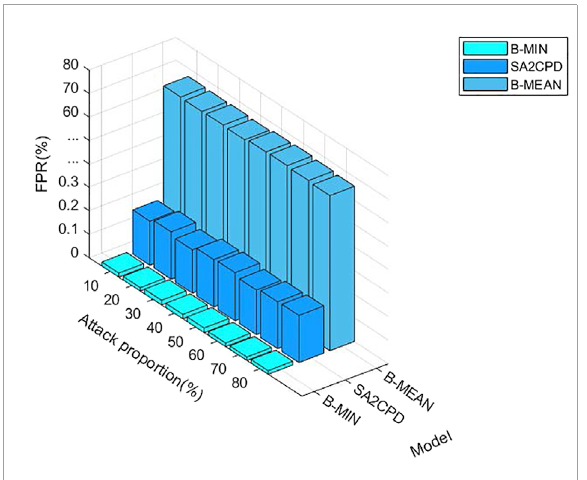
FIGURE 5 The FPR of our SA2CPD model, the B-MIN model and the B-MEAN model under different attack proportions.